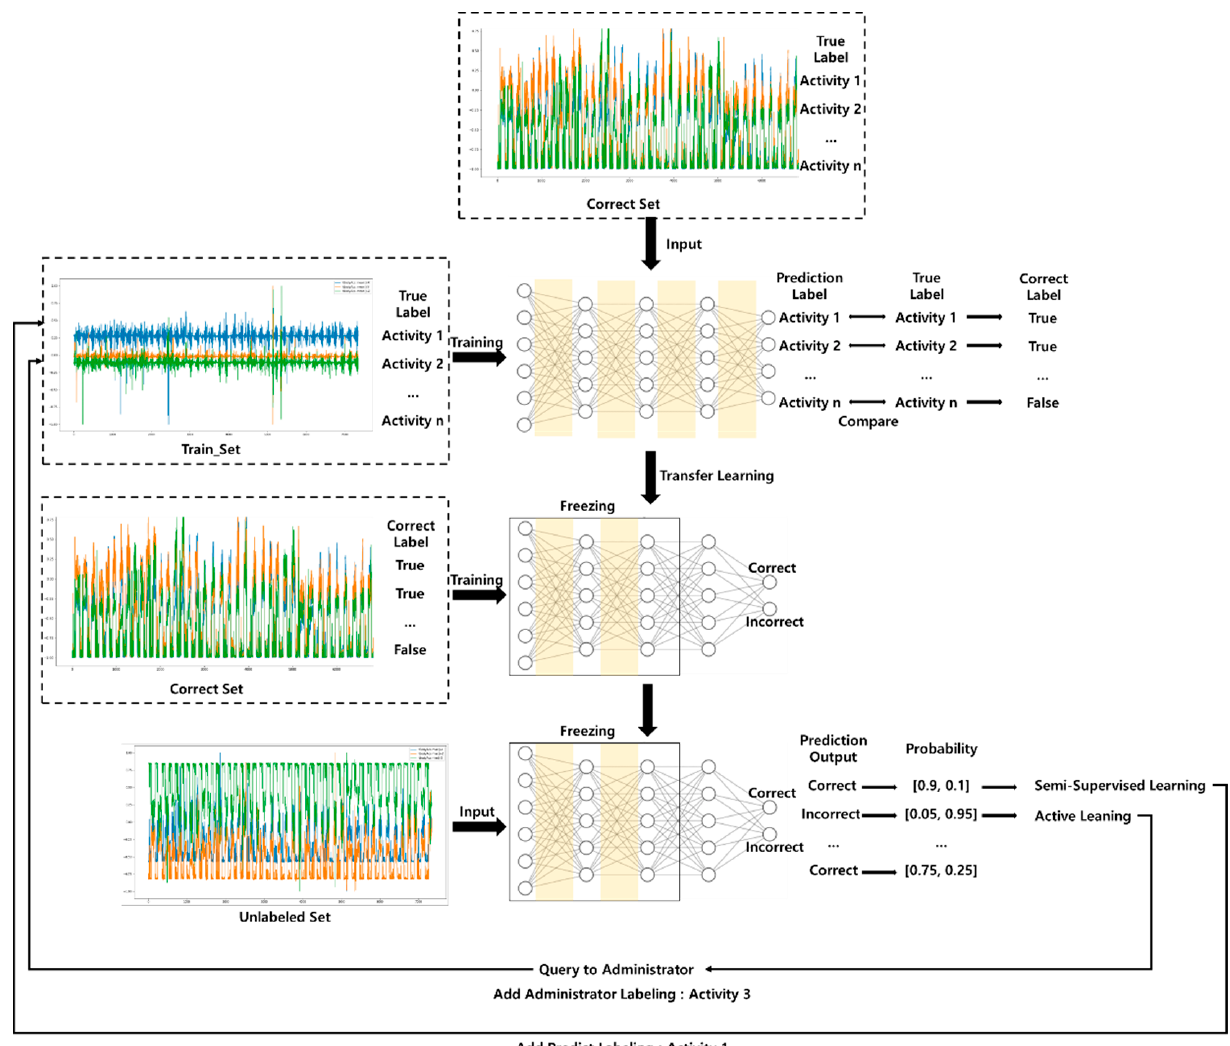
Figure 6. Training of semi-supervised active transfer learning architecture.